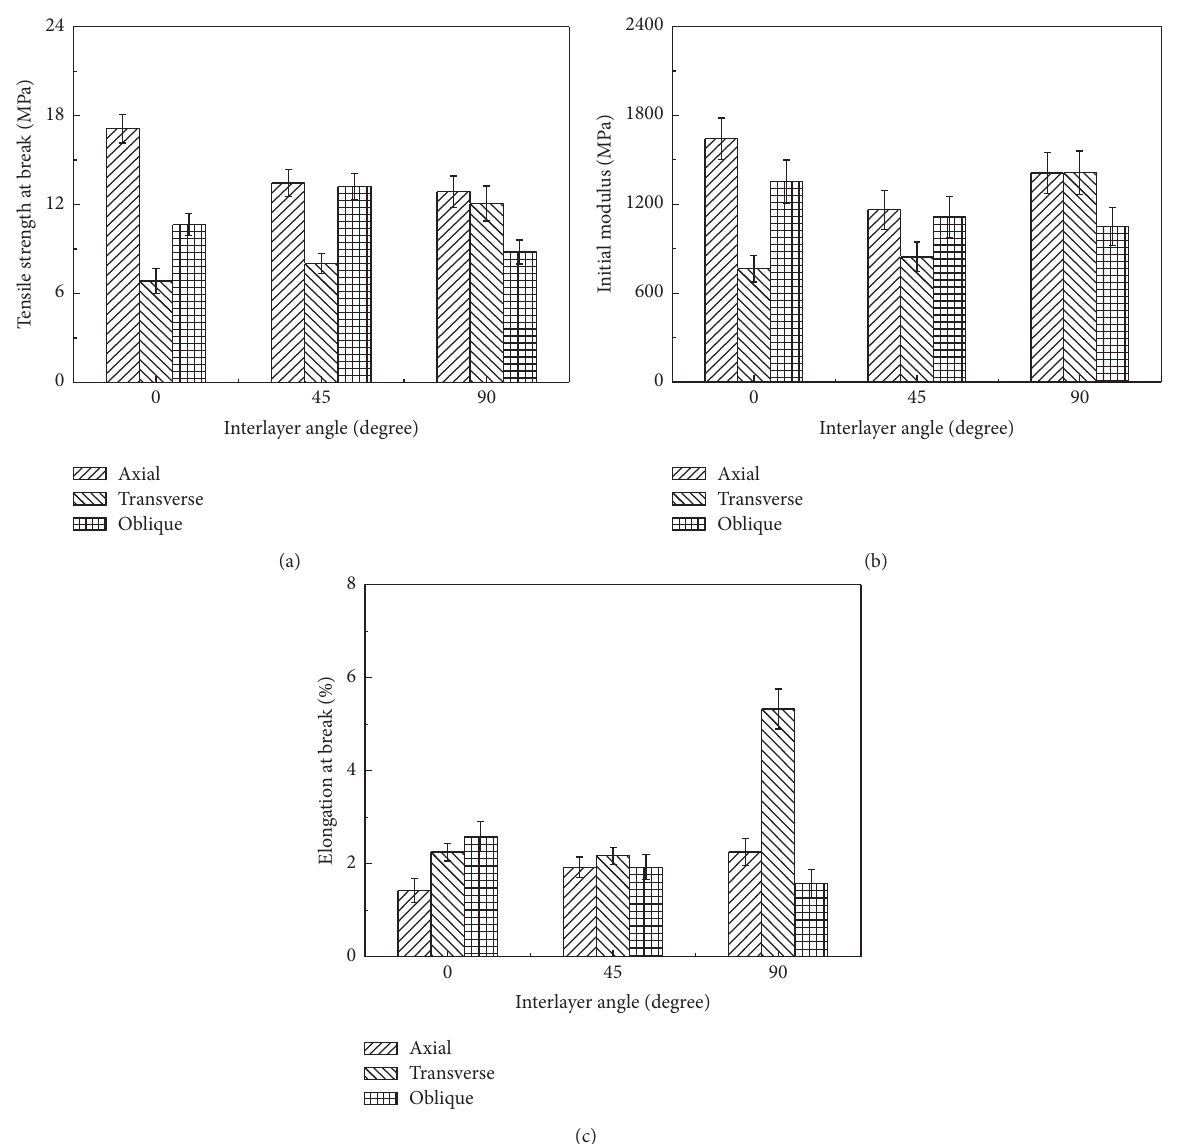
Figure 4: Mechanical properties of nanocomposites: tensile strength (a), initial modulus (b), and elongation (c).